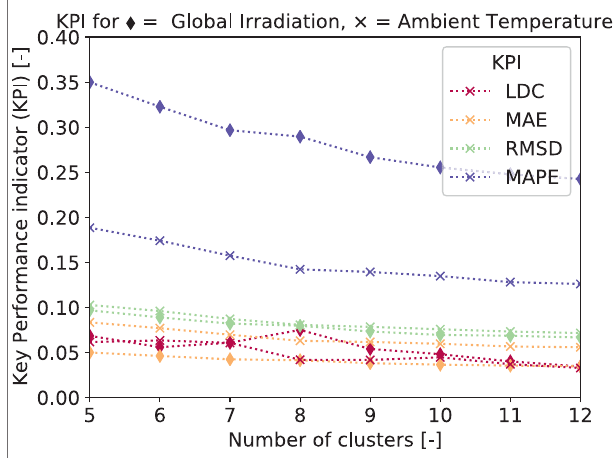
FIGURE 7 | KPI for different number of k-medoid clusters: load duration curve (LDC), mean average error (MAE), root mean square deviation (RMSD) and mean average percentage error (MAPE). Selected number of clusters is 10 additional to two extreme periods. Typical weather data for Geneva Switzerland (DOE, 2020).